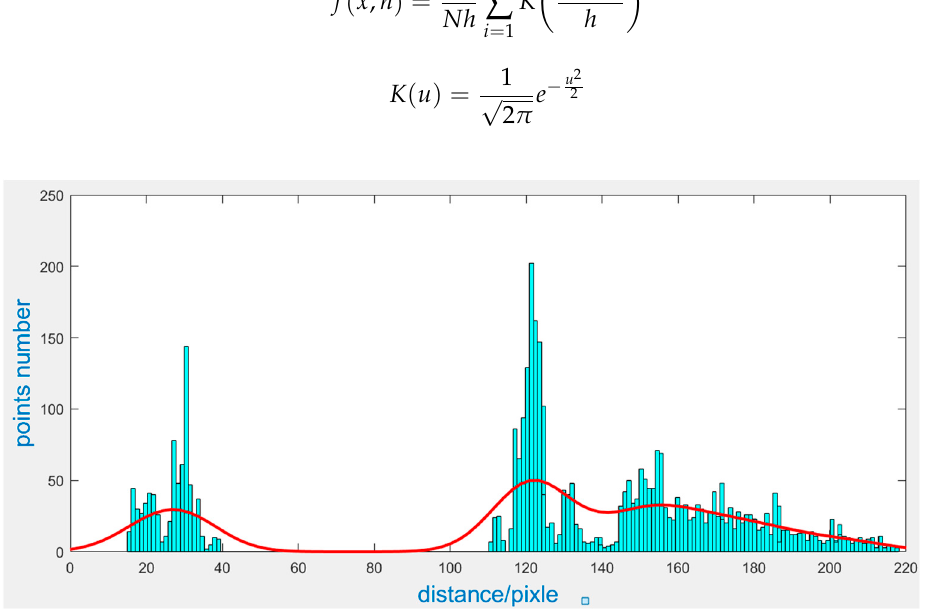
Figure 11. Kernel density estimation curve.